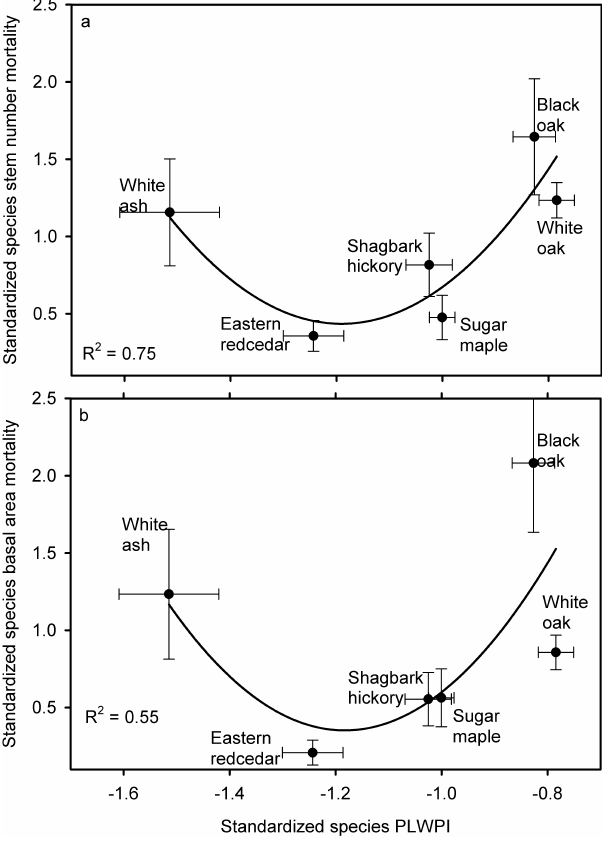
Figure 11. The mean standardized species mortality as a function of the mean standardized PLWPI. In each year and for each species, the standardization is done by dividing a species mortality by the community mortality or by dividing a species PLWPI by the abso- lute value of the community PLWPI. The standardized yearly values are then averaged across the years. The standardization preserves the relative positions of species in the PLWPI continuum. Mortal- ity is either expressed based on stem number density (a) or basal area (b) . This figure shows that species occupying middle posi- tions along the relative PLWPI continuum suffered less mortality than those at either extremes (i.e., extremely high or low relative